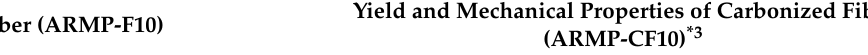
Table A2. The results of the stabilization under atmospheric and pressurized conditions using laboratory stabilization apparatus, yields, and mechanical properties of carbonized